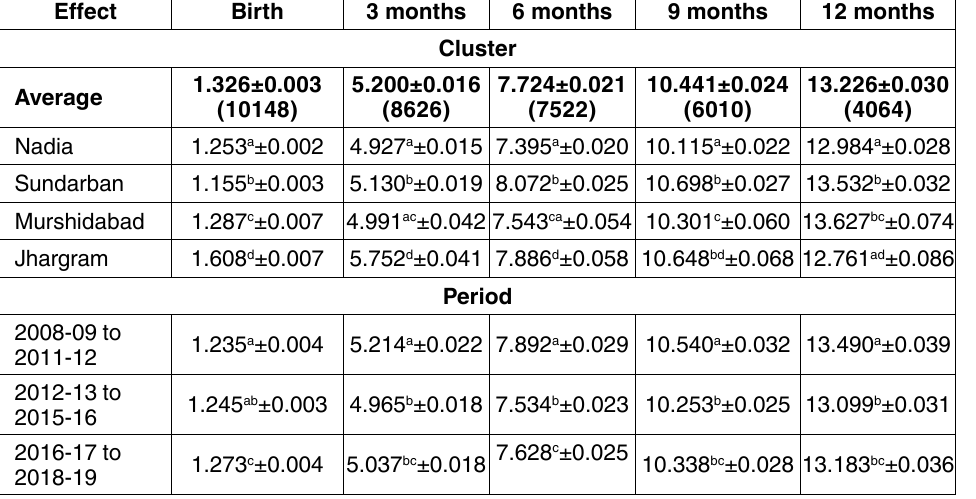
Table 1. Cluster and period wise variation of body weight (Mean ± SE) of Black Bengal